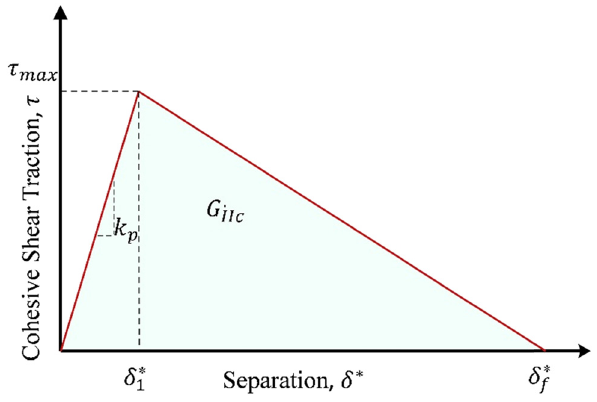
Figure 4: Bilinear cohesive zone model.